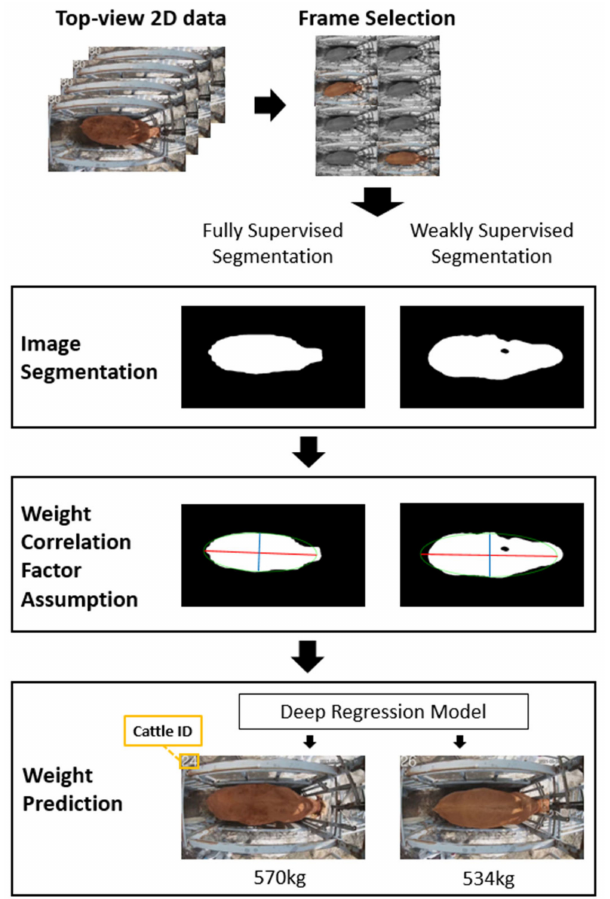
Figure 2. Flow chart of our cattle weight estimation